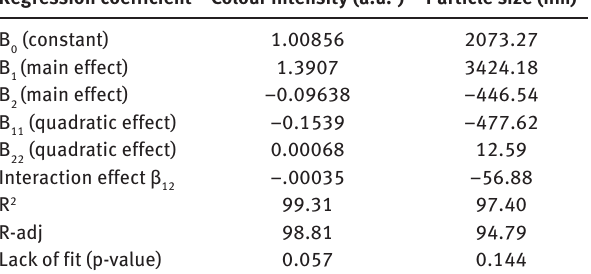
Table 2: Regression coefficients, R 2 , R 2 -adj, and probability values for the fitted models.